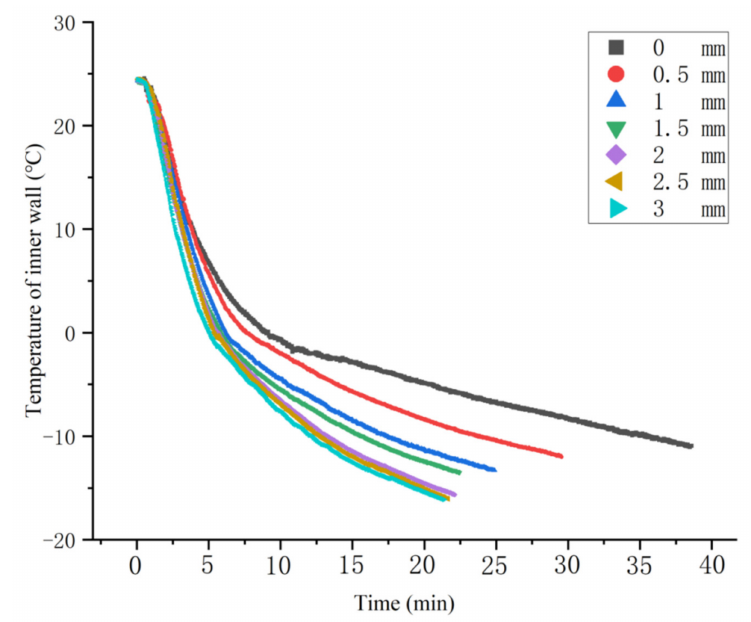
Figure 9. Relationship between the inner wall temperature and